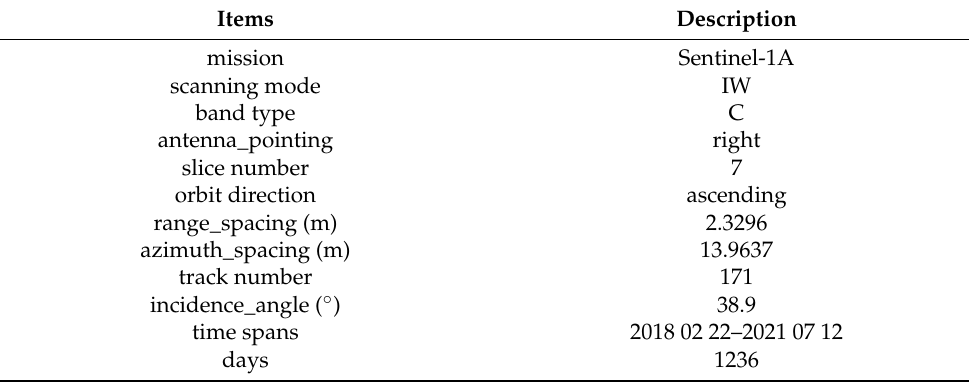
Table 1. Specific information of SAR images (Dates are in the format yyyy mm dd). Items